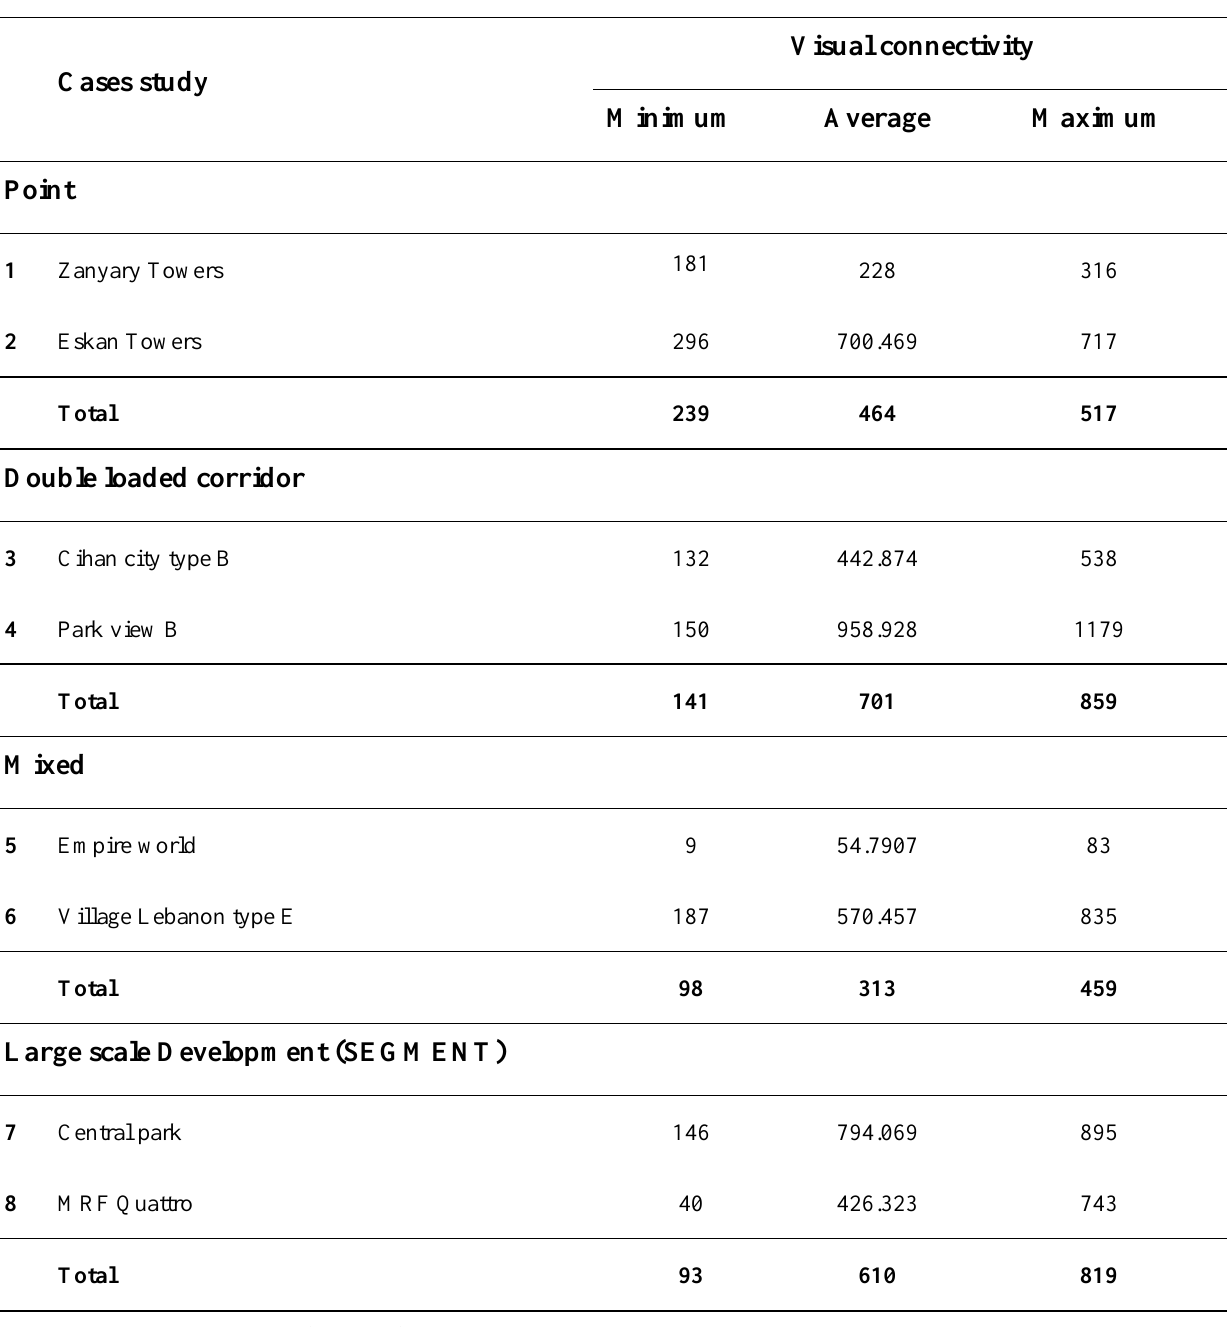
Table 1 . Numerical visual connectivity results of all cases study